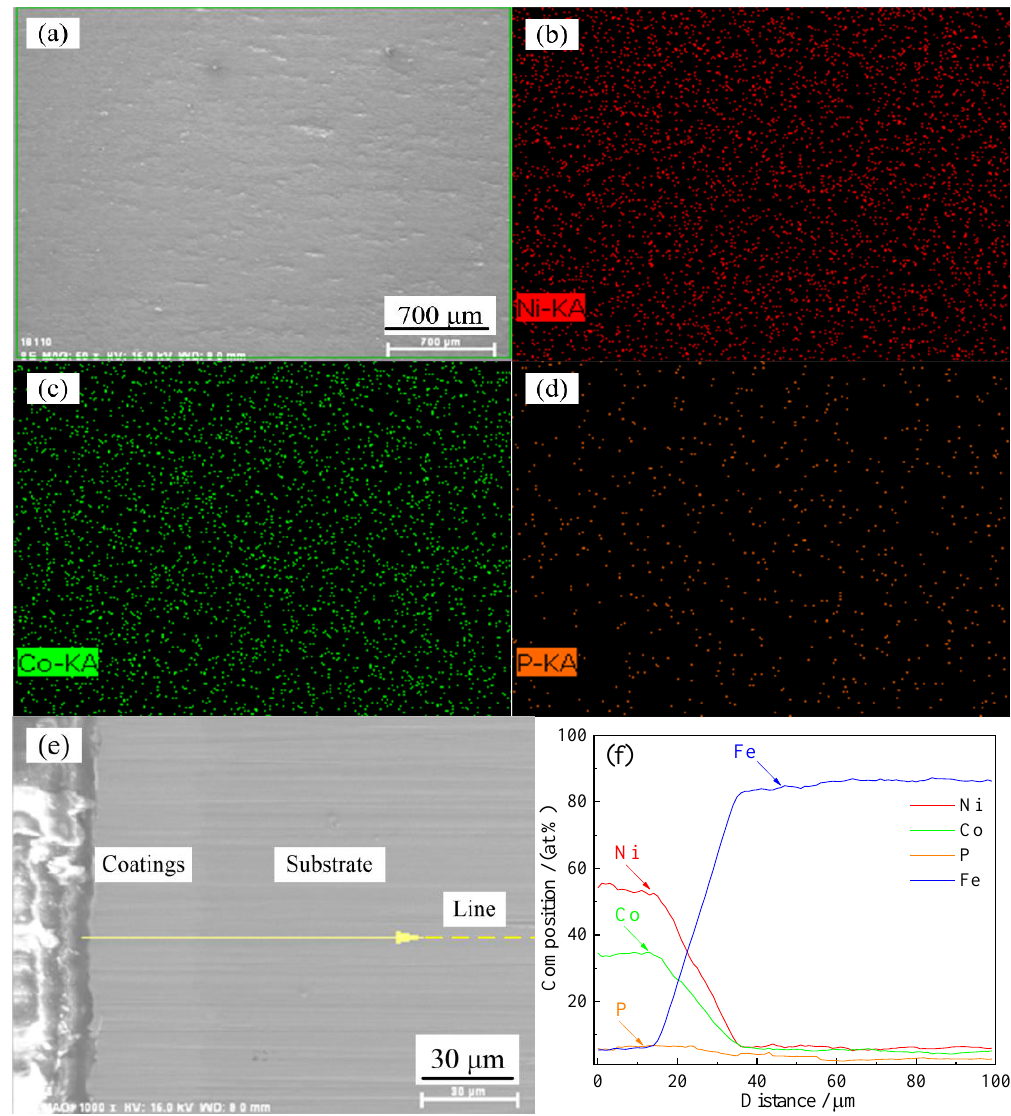
Figure 4. ( a ) SEM images in secondary electrons mode; ( b ) elemental mapping images of Ni; ( c ) elemental mapping images of Co; ( d ) elemental mapping images of P; ( e ) cross section of the samples; and ( f ) EDS linear scanning results of the samples.